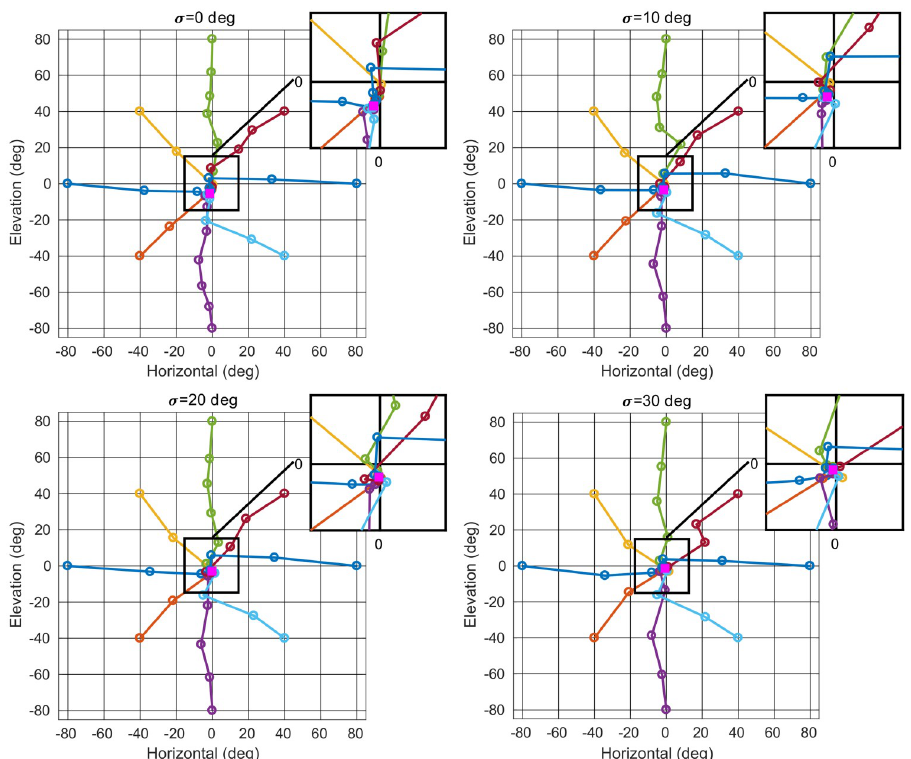
Fig 3. Example trajectories. Each figure shows examples of target direction in head-centered coordinates as the head direction is controlled by our model. Different colored trajectories illustrate eight initial target directions. Perfect localization corresponds to bringing the target direction to (0,0). Each circle marker indicates the target direction at iteration t 2 {1, ... ,20}. The target direction converges to a point attractor (solid square). The inset shows a magnified view of the center region. The point attractor moves closer to (0,0) direction as the standard deviation of head roll σ increases.